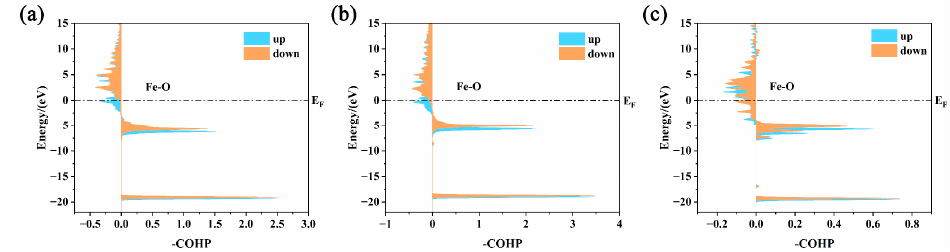
Figure 7. COHP of pure γ -Fe and H/N-containing austenite adsorbed with atomic oxygen. ( a – c ) are the COHP of pure γ -Fe and H/N-containing austenite adsorbed with atomic oxygen, respectively.